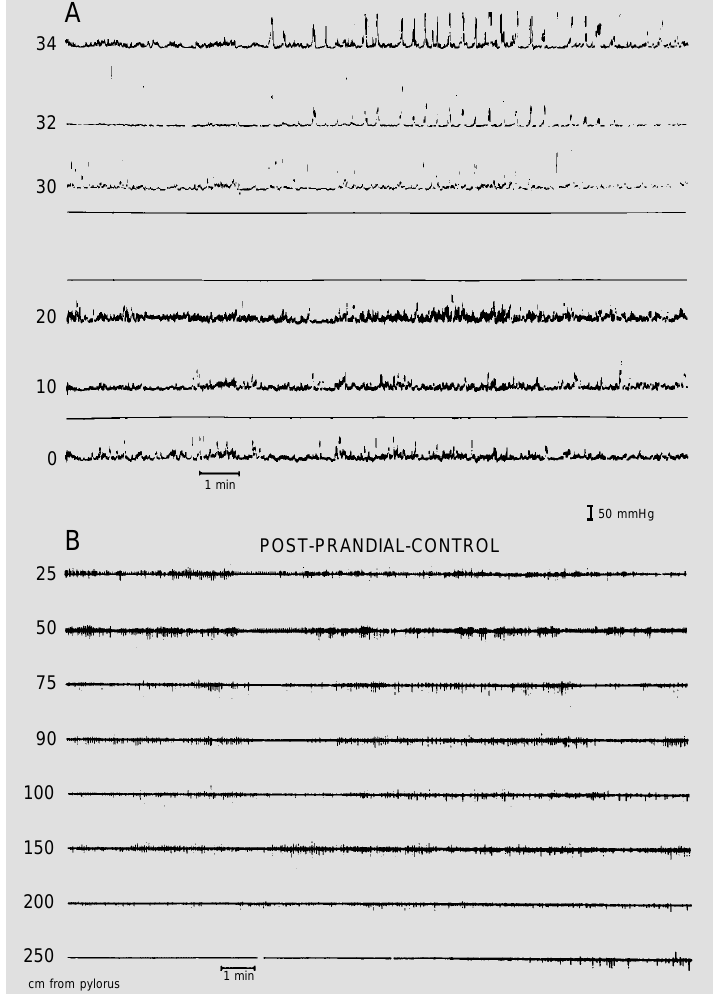
Figure 4 - The postprandial motor response. On feed- ing, migrating motor complex activity is lost and, as illustrated in recordings of intraluminal pressure activ- ity (A) and myoelectrical activity (B) from the proximal small intestine in man and dog, respectively, is re- placed by intense irregular